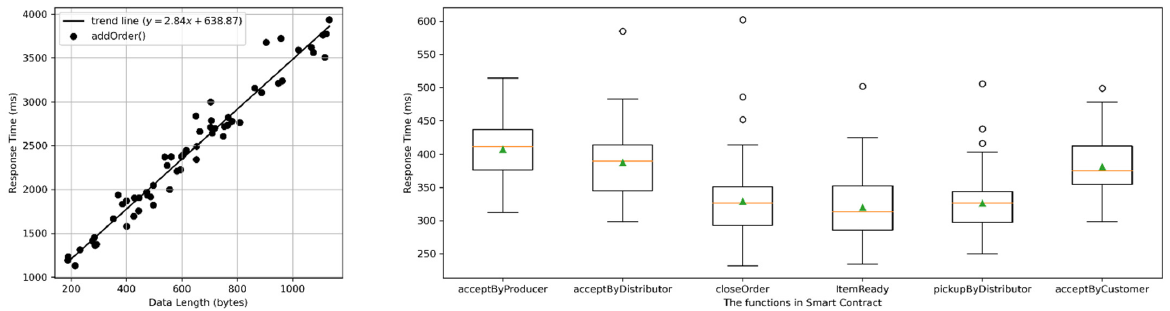
Figure 5. The response time of addOrder() increases as a linear function ( y = 2.84x + 638.87, R 2 = 0.9802). Moreover, there is no significant correlation between the data length and response